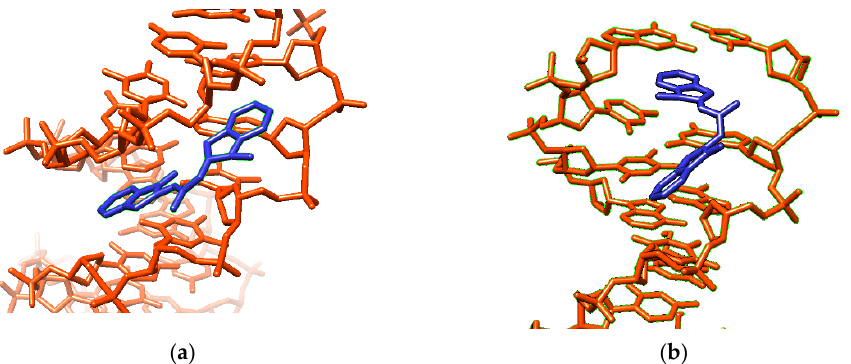
Figure 3. General scheme of noncovalent binding of a trimethine cyanine molecule to dsDNA: ( a ) binding in the minor groove of a DNA molecule and ( b ) intercalation between DNA base pairs, with 3,3 ′ ,9 ‐ triethylthiacarbocyanine (Cyan 2, 1 ) molecules taken as an example (blue ‐ colored molecules). The scheme was obtained by molecular docking.